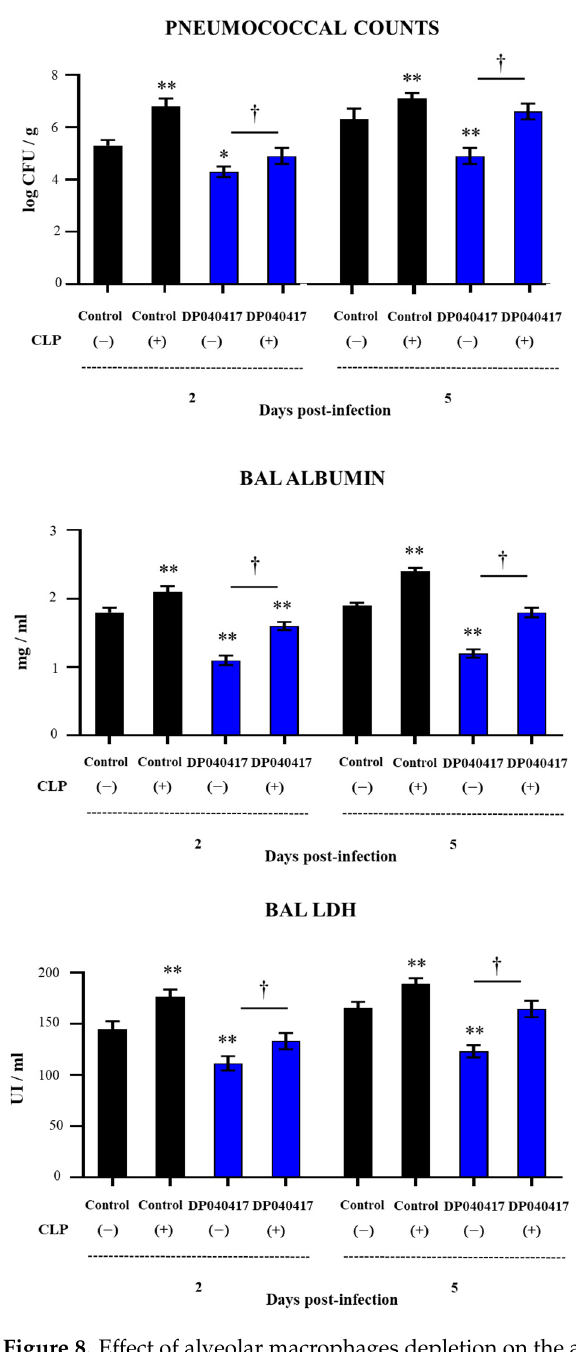
Figure 8. Effect of alveolar macrophages depletion on the ability of the respiratory commensal bacteria Dolosigranulum pigrum 040417 to improve protection against Streptococcus pneumoniae infection. Infant mice were nasally treated with clodronate-containing liposomes (CLP) during 2 days (days 0 and 1) to induce the depletion of alveolar macrophages. One day after the last CPL administration, mice were nasally treated with viable D. pigrum (DP) strain 040417 (10 8 cell/mouse/day) during five consecutive days (days 2–6) and challenged with S. pneumoniae serotype 3 on day 7. Mice treated with liposomes and then challenged with S. pneumoniae were used as controls. Two and five days after the challenge with the pathogen, pneumococcal cell counts, lactate dehydrogenase (LDH) activity and albumin concentrations in broncho-alveolar lavages (BAL) were evaluated. The results represent data from three independent experiments ( n = 6 per each group at each time point). Significantly different when compared with control CLP ( − ) group, * p < 0.05 or ** p < 0.01. Significantly differences between the indicated groups, † p < 0.05.